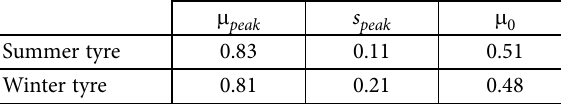
Table 1. Differences in slip referring to m peak adhesion coefficient